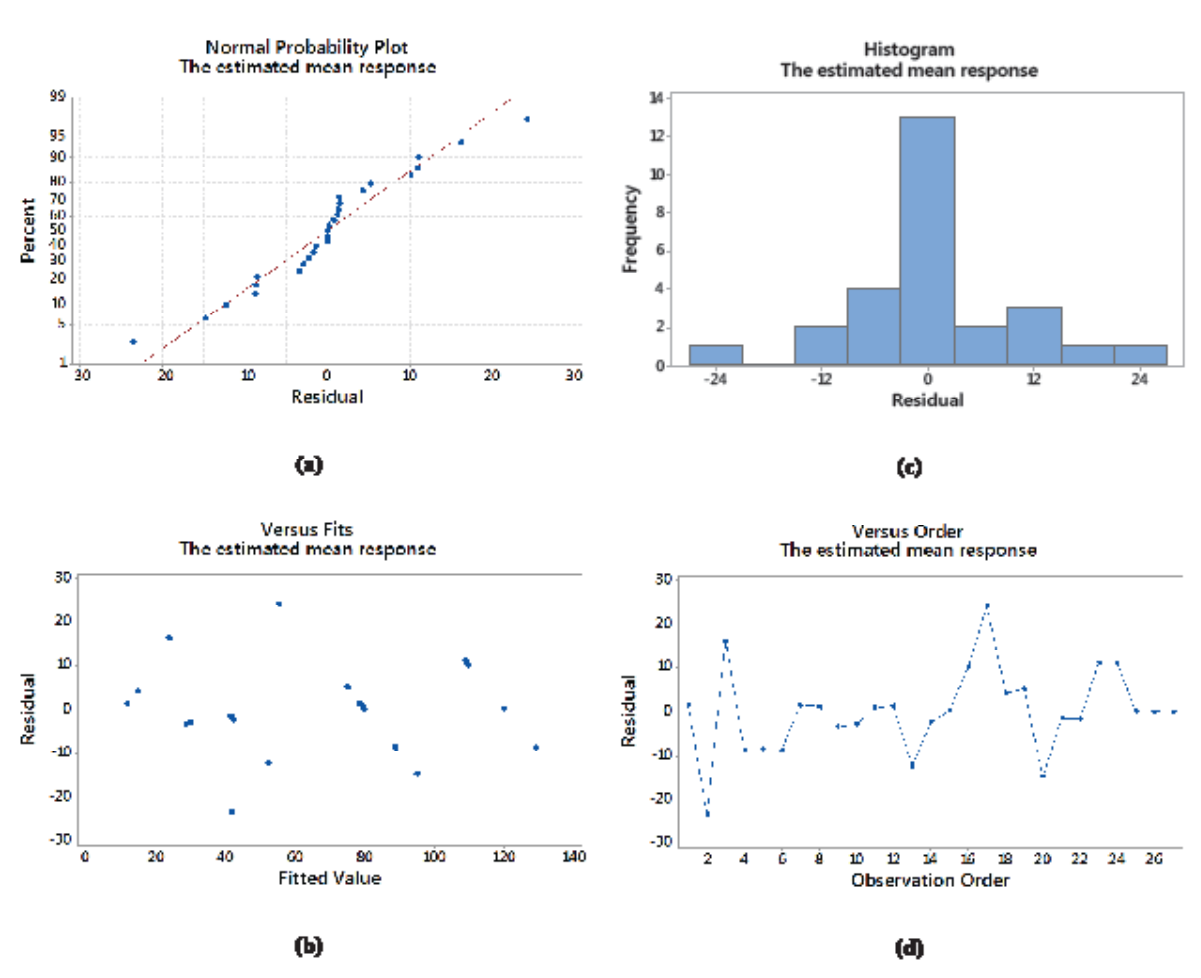
Figure 2: (a) Normal probability plot; (b) residual plot; (c) residual histogram plot; (d) residual versus order